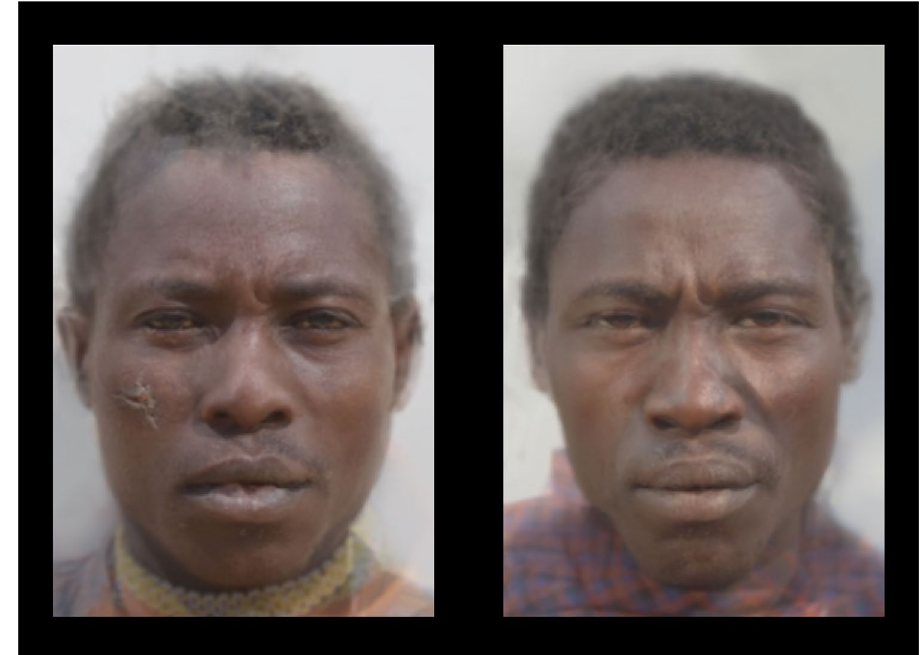
Figure 1. A sample set of composite male faces used in the experiment (face set M1, condition A). The complete set of stimuli are available at https:// osf. io/